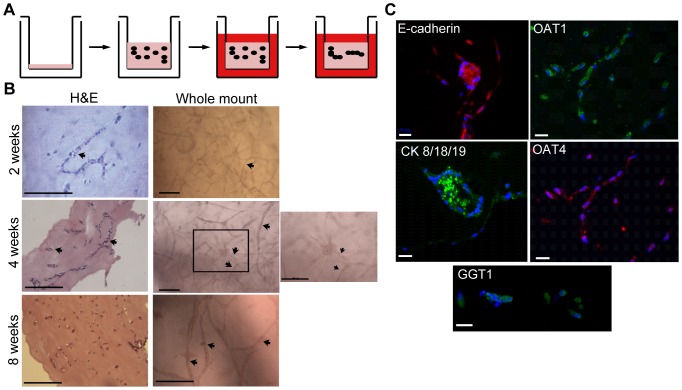
NKi-2 cells formed tubular structures when grown in 3D tissues.(A) Schematic of 3D tissue formation. An acellular layer of 1:1 Matrigel:rat tail collagen I (1 mg/mL) is layered onto a tran-well membrane. Following polymerization, a layer of the same ECM mixture containing NKi-2 cells is added. The tissues are maintained in growth media and after approximately 2 weeks, the cells organize into branching structures. (B) Morphology of NKi-2 cells after extended growth in 3D tissues. Tissue sections, 10 µm, were stained with H&E and whole tissue sections were stained with carmine for whole mounts. Arrows indicate areas of branching tubular-like structures. Scale bars  =  100 µm. (C) Expression of epithelial cell markers, e-cadherin (red) and cytokeratin 8/18/19 (green), kidney proximal tubule cell marker GGT1 (green) and organic anion transporters OAT1 (green) and OAT4 (red) within the 3D tissues after 4 weeks of growth. Scale bars  =  25 µm.